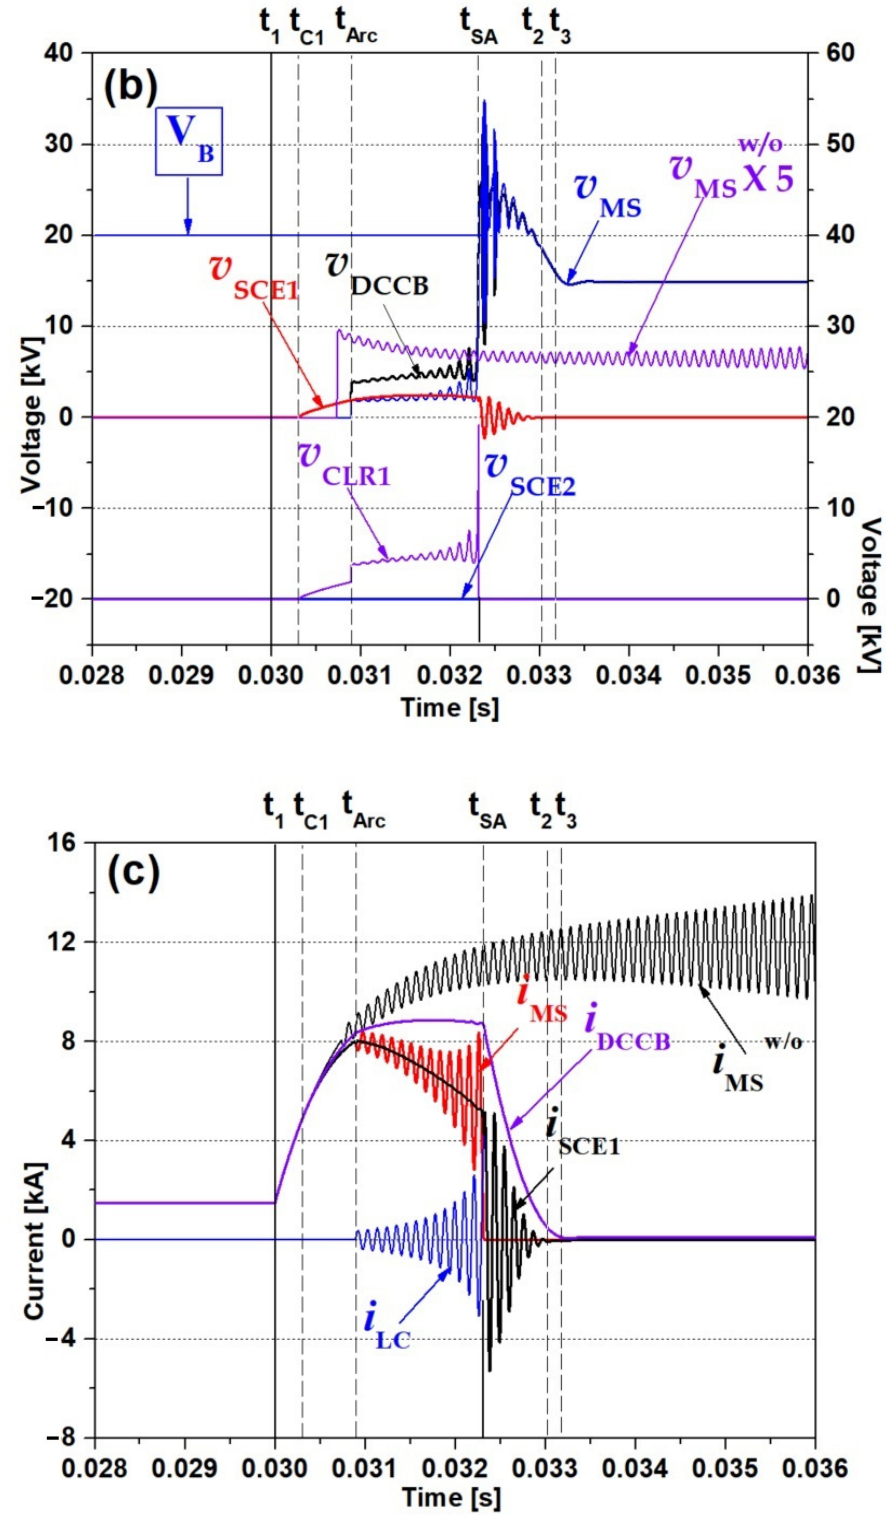
Figure 4. DC fault current limiting and interrupting operation waveforms of the hybrid DCCB using double quench in case of the lower DC fault current occurrence. ( a ) Current waveforms of DCCB, SCE 1 SCE 2 , CLR 1 , CLR 2 and SA ( i DCCB , i SCE1 , i SCE2 , i CLR1 , i CLR2 , i SA ). ( b ) Voltage waveforms of DCCB, MS, SCE 1 , SCE 2 , CLR 1 ( v DCCB , v MS , v SCE1 , v SCE2 , v CLR1 ). ( c ) DC current limiting and interrupting waveforms of DCCB, MS, LC, SCE 1 ( i DCCB , i MS , i LC , i SCE1 ).